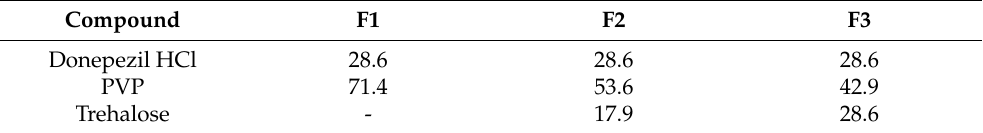
Table 2. The composition of the donepezil-loaded DMN patch used for the in vitro drug release study (% w / w